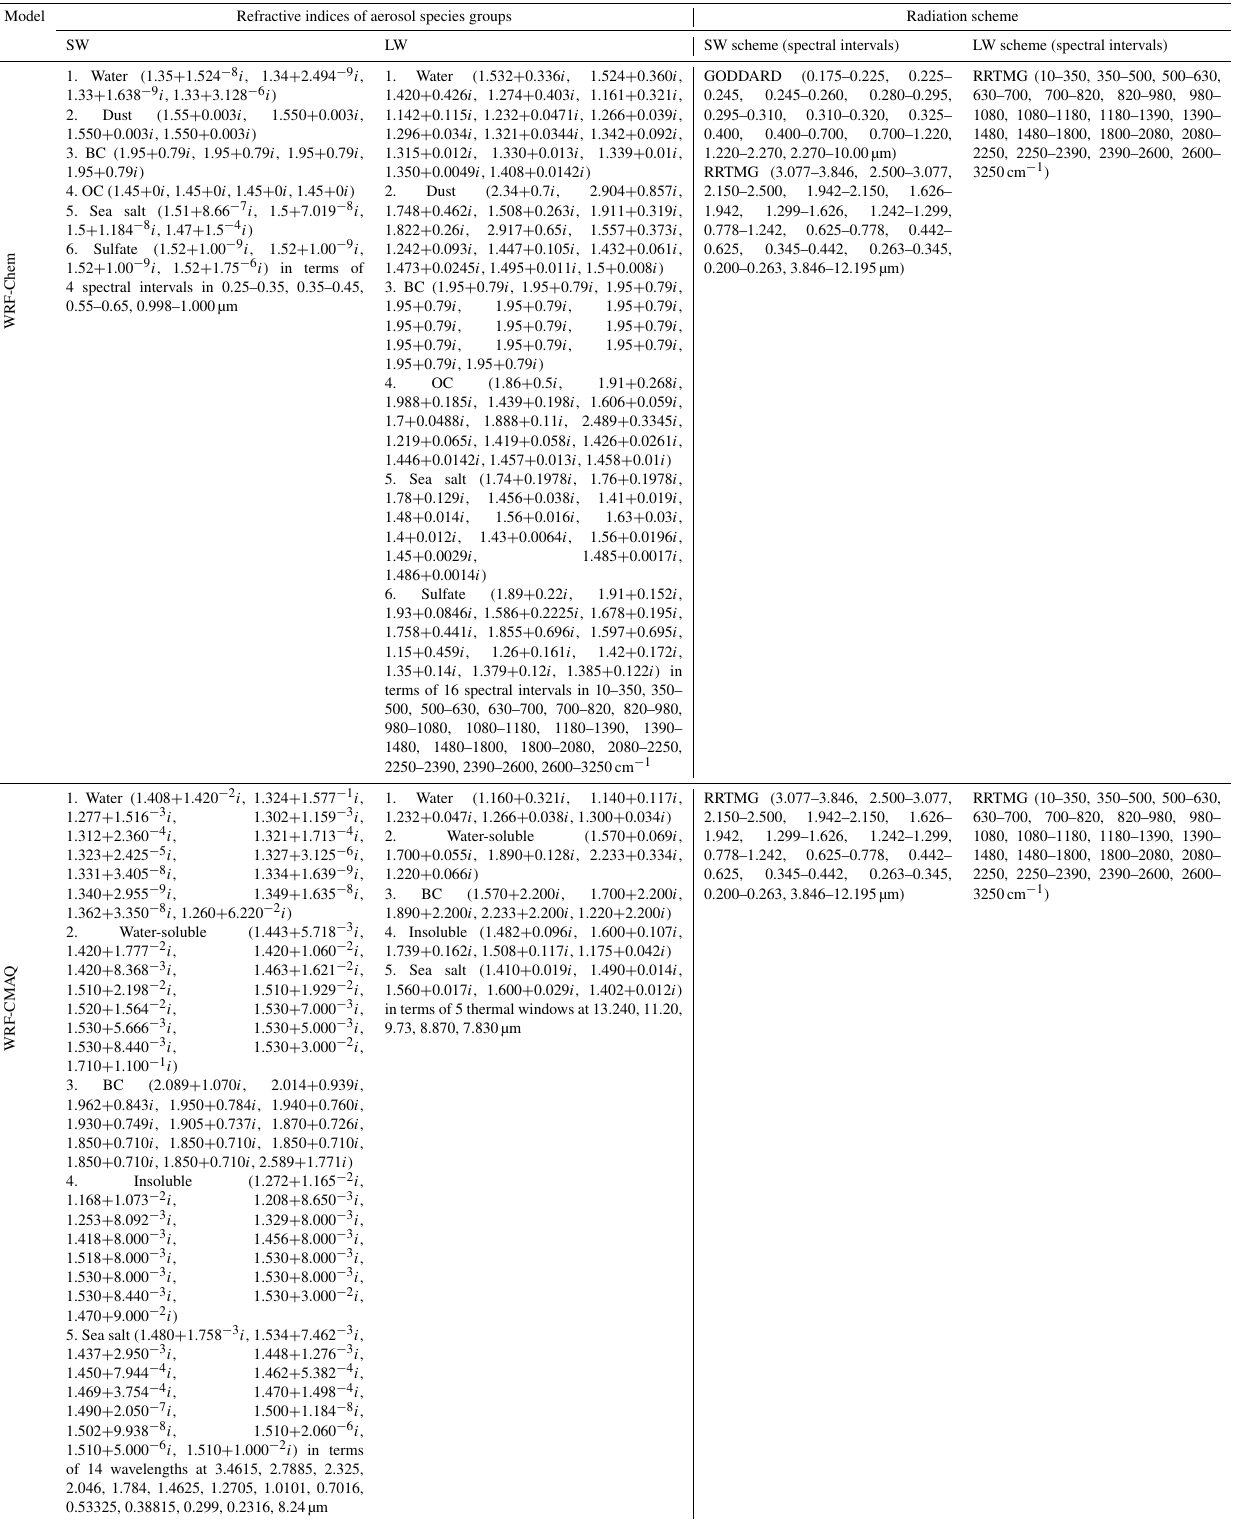
Table B6. Description of refractive indices and radiation schemes used in the WRF-Chem and WRF-CMAQ in Asia.